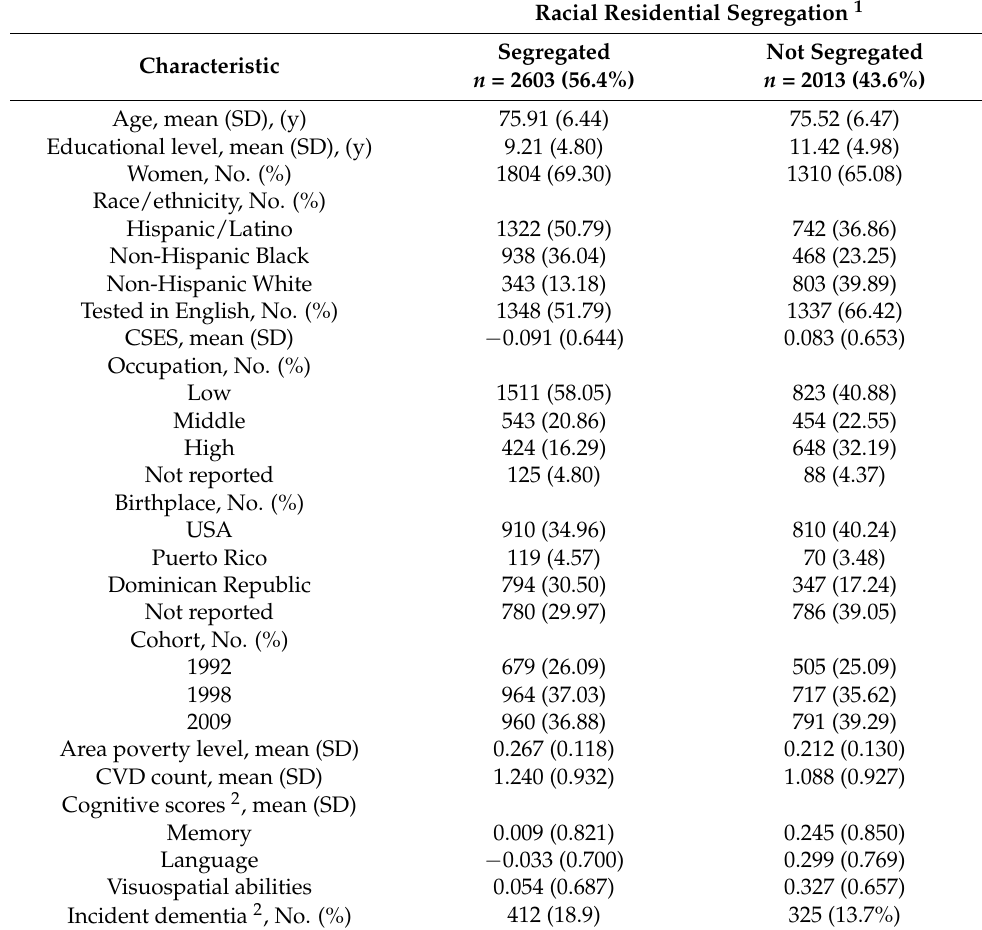
Table 1. Sample characteristics at baseline stratified by racial residential category. Racial Residential Segregation